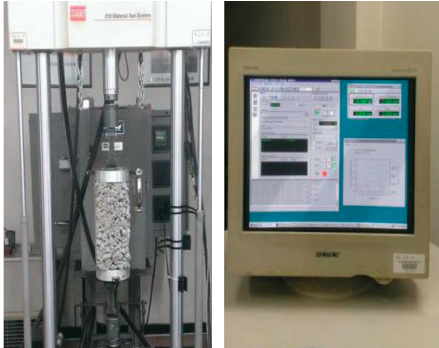
Figure 18: Test of compressive elastic